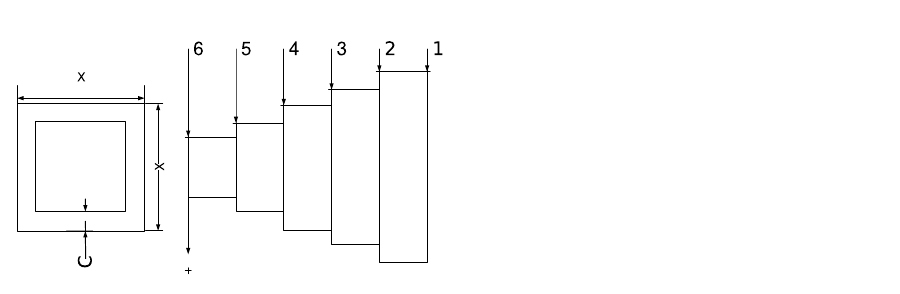
Figure 11. Schematic of cantilever